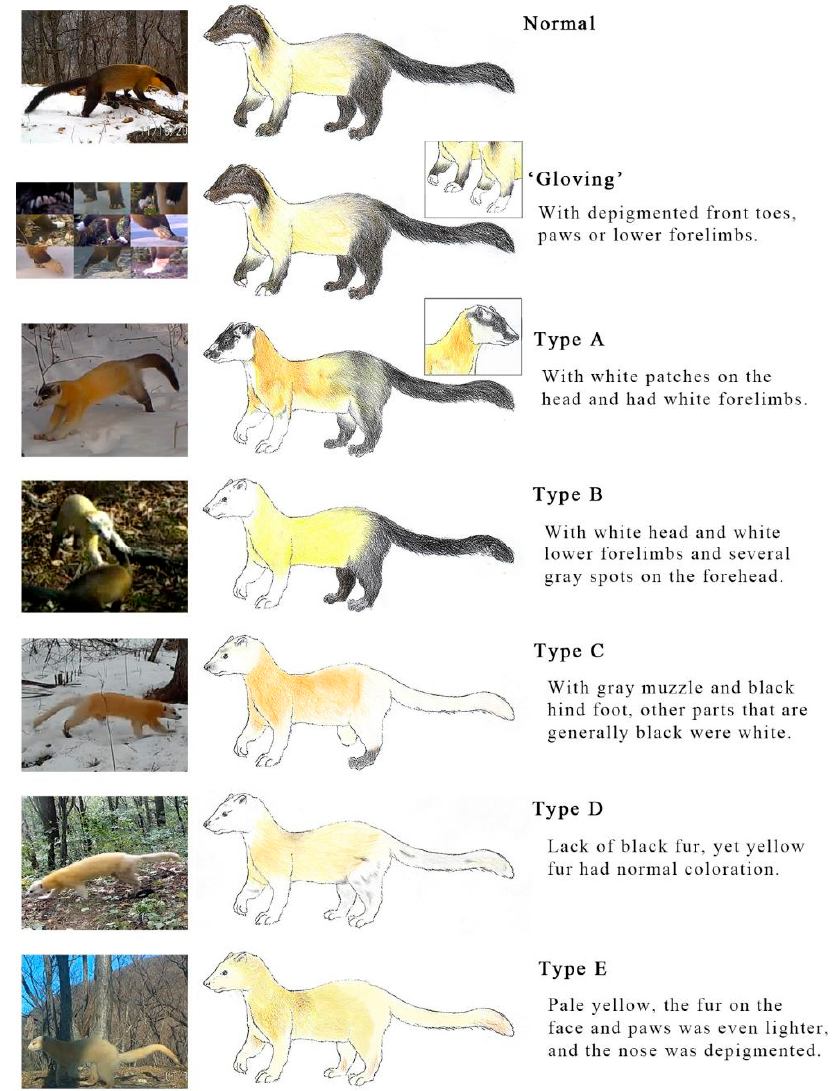
Figure 2. Hand painting and camera trap records of abnormally-colored yellow-throated martens in Northeast Tiger and Leopard National Park, Northeast China. Type C is a mirror painting.